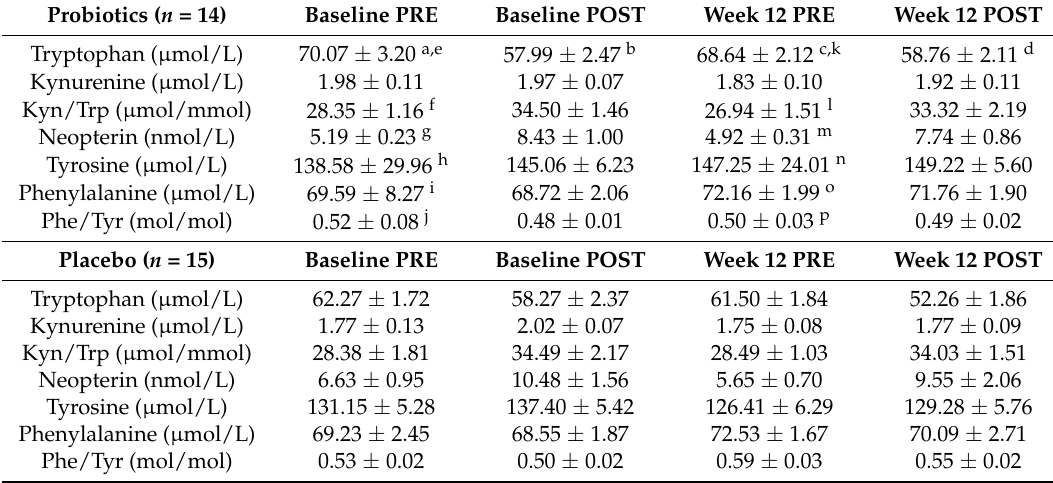
Table 3. Amino acids and immune biomarkers in 29 athletes before and after 12 weeks of treatment either supplemented with probiotics or placebo measured before (PRE) and after exercise